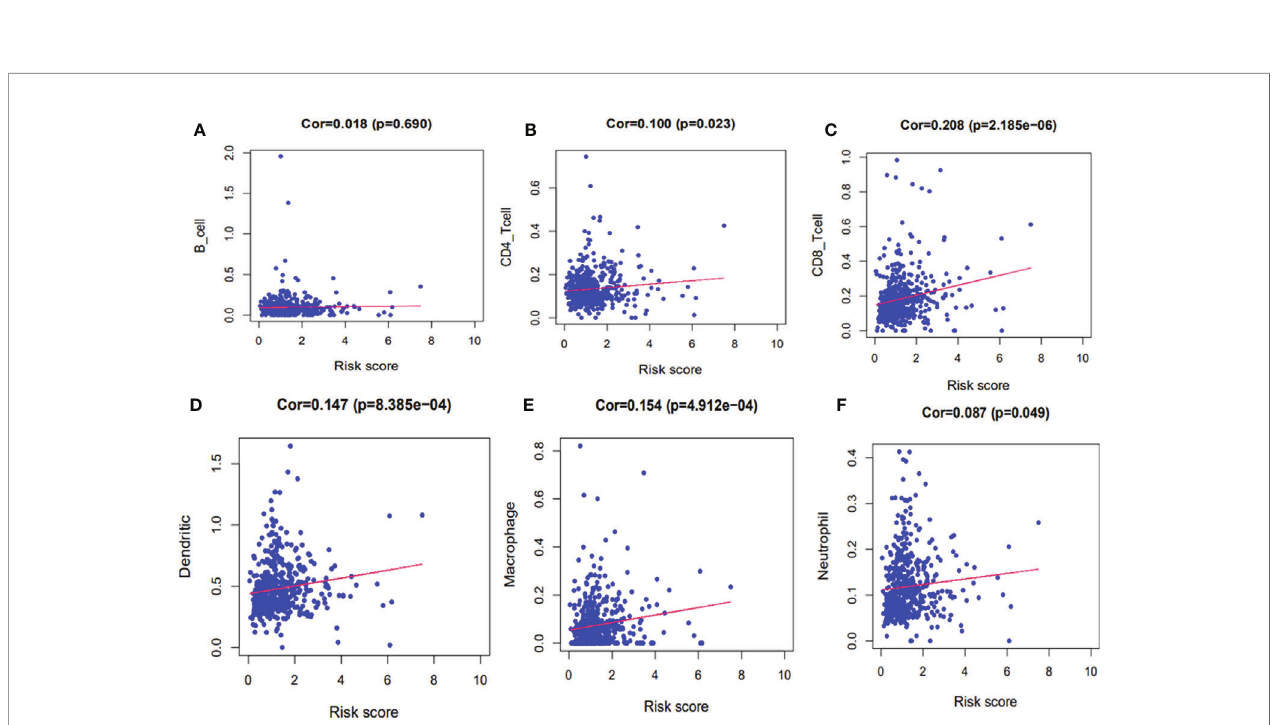
FIGURE 10 | The immune correlation analyses of the signature. (A) B cells. (B) CD4+ T cells. (C) CD8+ T cells. (D) Dendritic cells. (E) Macrophages. (F)